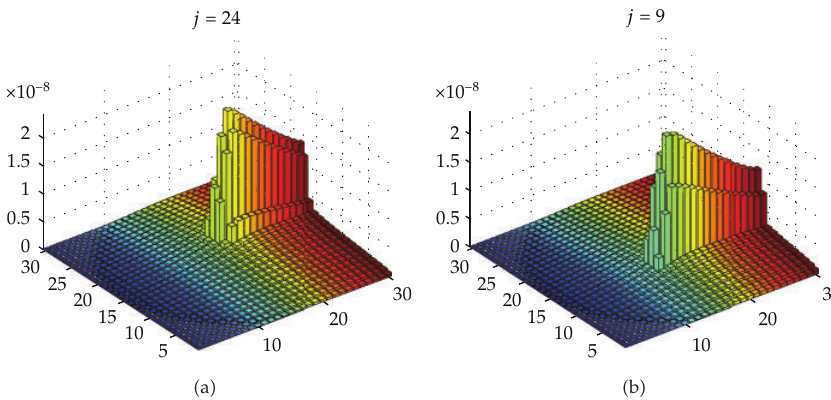
Figure 8: Absolute error in view 24 and 9 angular test flux for the